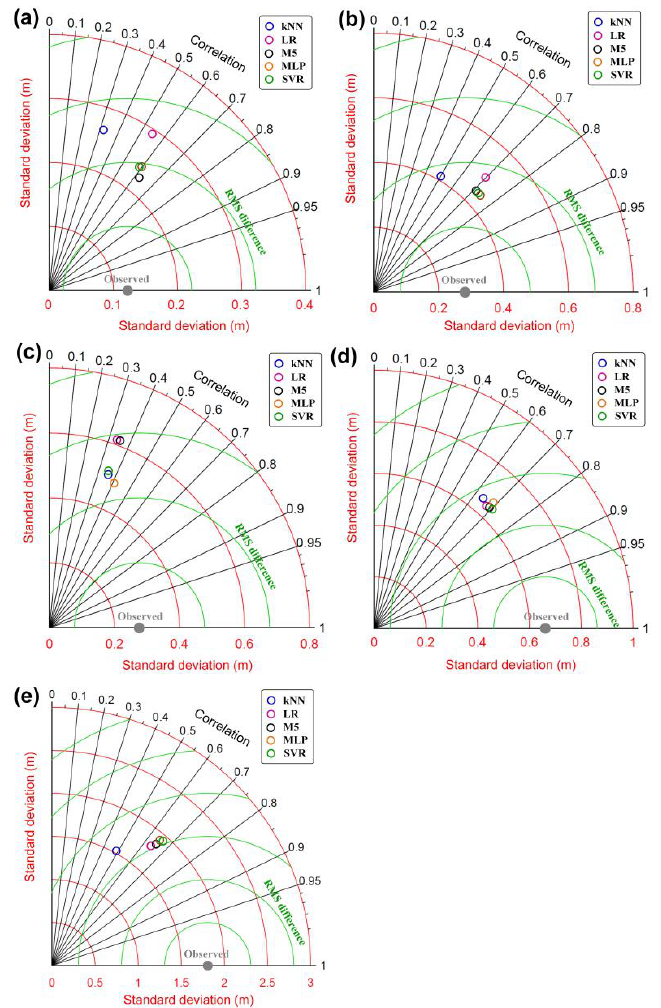
Figure 9. Taylor diagrams for: ( a ) small wavelet, ( b ) large wavelet, ( c ) small/moderate wave, ( d ) long wave, and ( e ) high/very high